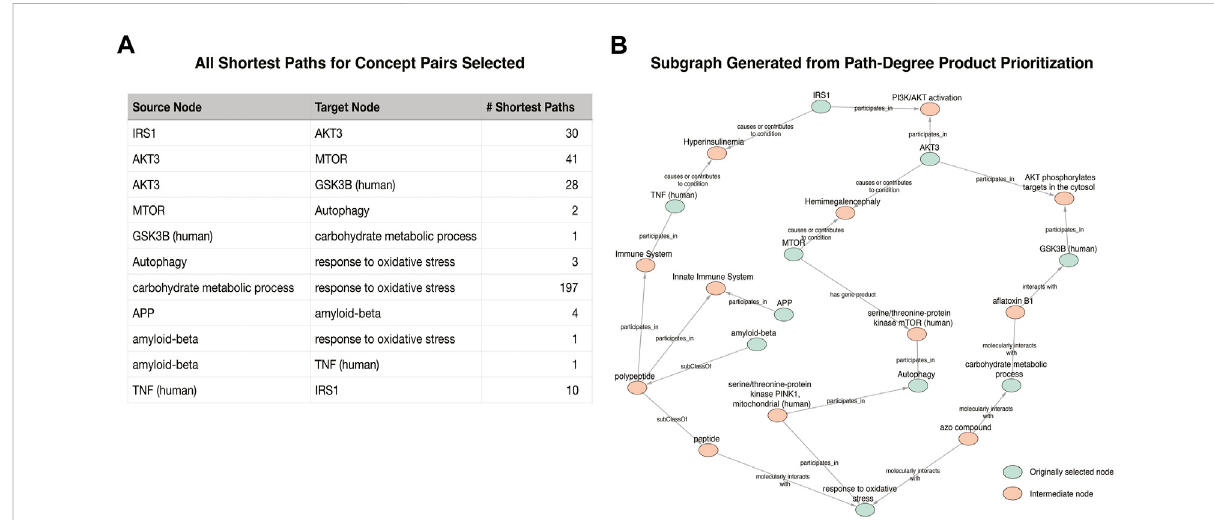
FIGURE 4 VisualizationofthesubgraphgeneratedfortheFigure1Aexample. (A) Thenumberofshortestpathsfoundforeachpairidenti fi edintheoriginal cartoon. (B) The result of the Path-Degree Product based ranking algorithm that prioritized one path for each original pair of nodes.